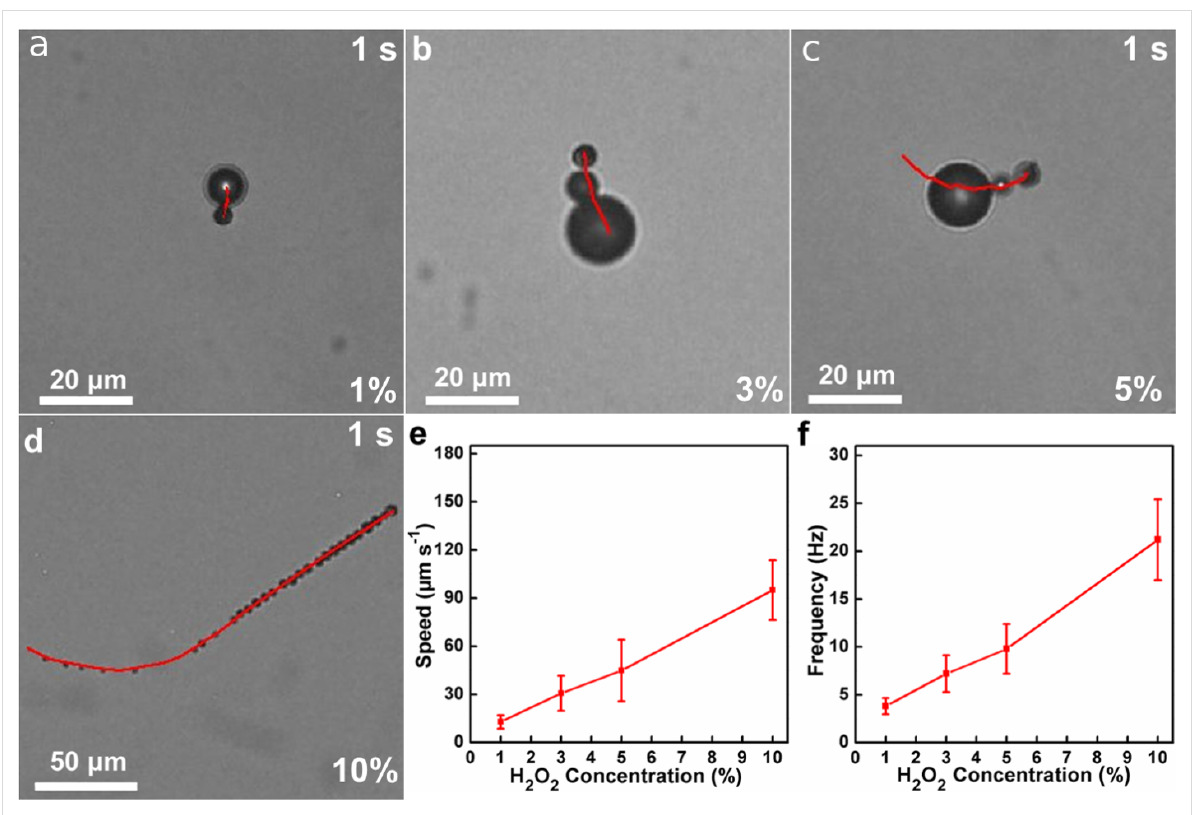
Figure 2: Images of the Janus UCNP capsule motors for different H 2 O 2 concentrations: (a) 1%, (b) 3%, (c) 5% and (d) 10% after a period of 1 s. (e) Effect of the H 2 O 2 concentration on the average speed of the Janus UCNP capsule motors. (f) Relationship of the oxygen bubble expulsion fre- quency of Janus UCNP capsule motors with different H 2 O 2